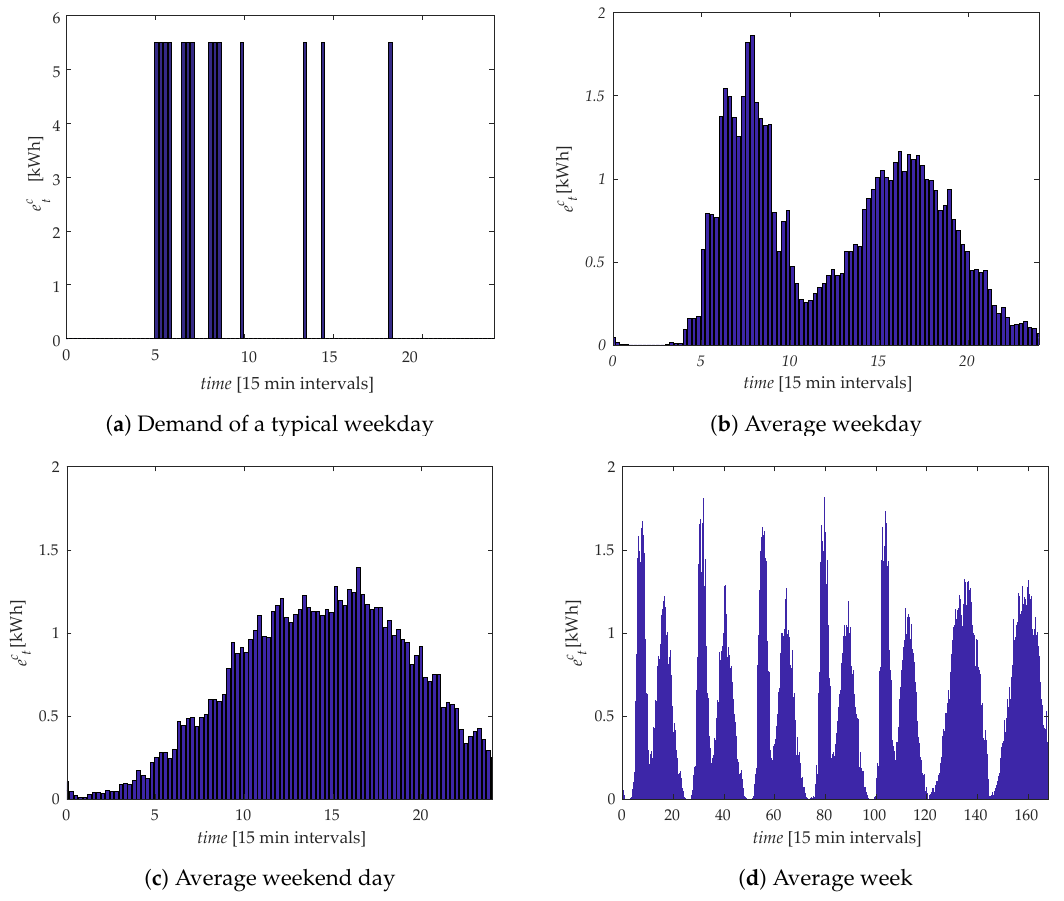
Figure 5. Average consumed energy in each interval for a N =